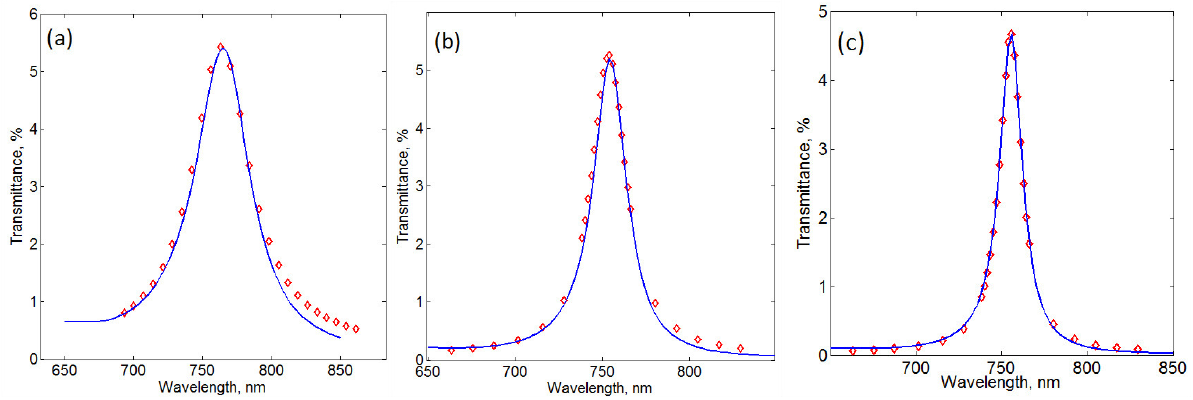
Figure 4. Transmittance spectra for the sample-1 with Au layer on top ( a ), the sample-2 with Au layer on top ( b ), and the sample-3 with Au layer on top ( c ). Solid lines show the calculation results, and the diamond shapes represent the experimental data. See in the text for the details on t and q i i